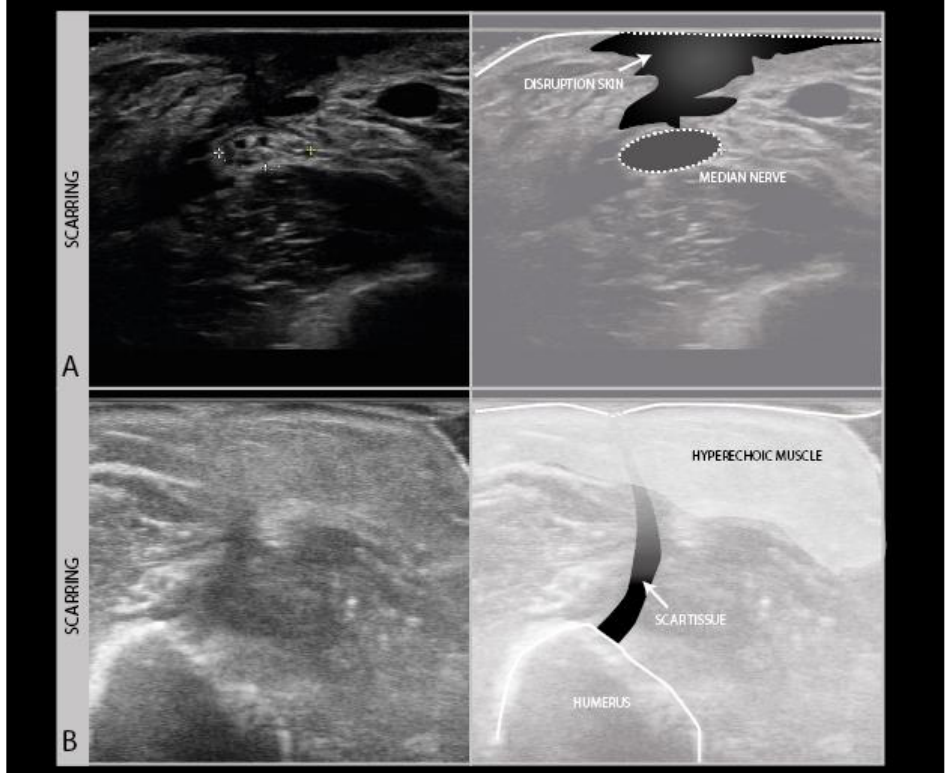
Figure 8. Examples of scarring of the skin and subcutis. Severe disruption of skin and subcutaneous tissue showing as a craggy hypoechogenic region over a median nerve neuroma in continuity in a patient with the piercing trauma of the forearm by a wooden fence ( A ). Hyperechogenic subcutis and muscle following surgery for an open humerus fracture, with a subtle vertical scar line interrupting the tissue layers ( B ).